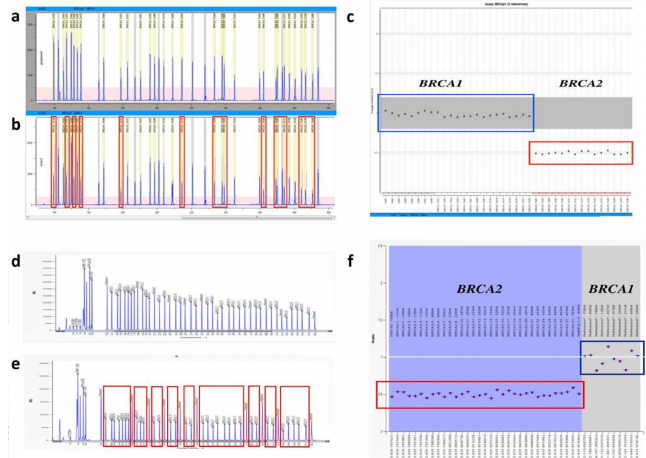
Figure 3. Multiplex Amplicon Quantification (MAQ) ( a – c ) and Multiplex Ligation-dependent Probe Amplification (MLPA) ( d – f ) analysis results of BRCA2 gene deletion. ( a ) MAQ electropherogram (Plex 1) from a wild type sample. ( b ) MAQ electropherogram (Plex 1) from the patient carrying whole BRCA2 deletion, the peaks belonging to BRCA2 are grouped in red boxes. ( c ) MAQ results by means of Dosage Plot obtained by MAQ-S v2.0 software. It shows an overview of all amplicons and their individual Dosage Quotient indicating the Copy Number. ( d ) MLPA electropherogram from a wild type sample and ( e ) MLPA electropherogram from the patient carrying BRCA2 deletion where the peaks belonging to BRCA2 are grouped in red boxes. ( f ) MLPA results: Blue rhombus, black crosses and red triangles indicate, respectively, the maximum, average and minimum values of each probe within the experiment. Probes relative to BRCA2 show a RPR value of about 0.5 (red box) compared to the normal range value of reference probes (blue box, value: 0.7–1.3), thus indicating ( BRCA2 ) exons